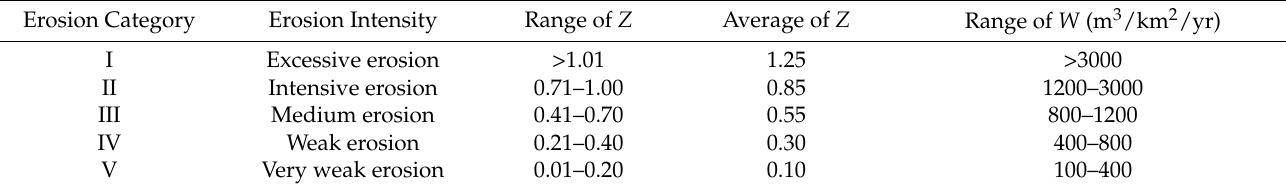
Table 2. EPM erosion categorization and range of the erosion coefficient ( Z